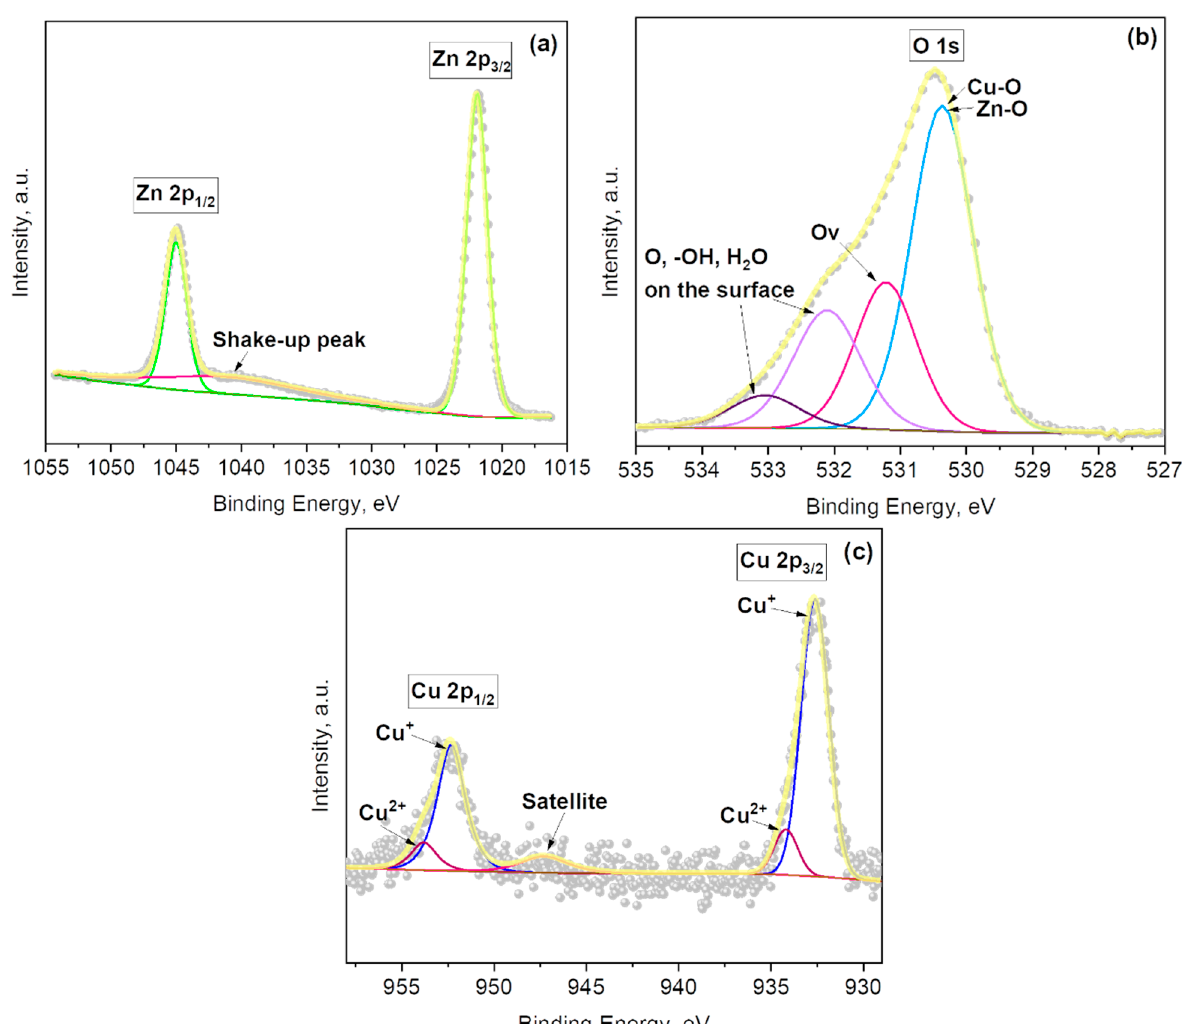
Figure 9. ( a ) Zn 2p, ( b ) O 1s, and ( c ) Cu 2p core levels XPS spectra for Cu 2 O@ZnO film. Grey dots represent the raw data, the solid yellow line corresponds to the envelope/fitting curve, and the other colored curves to the deconvoluted components.